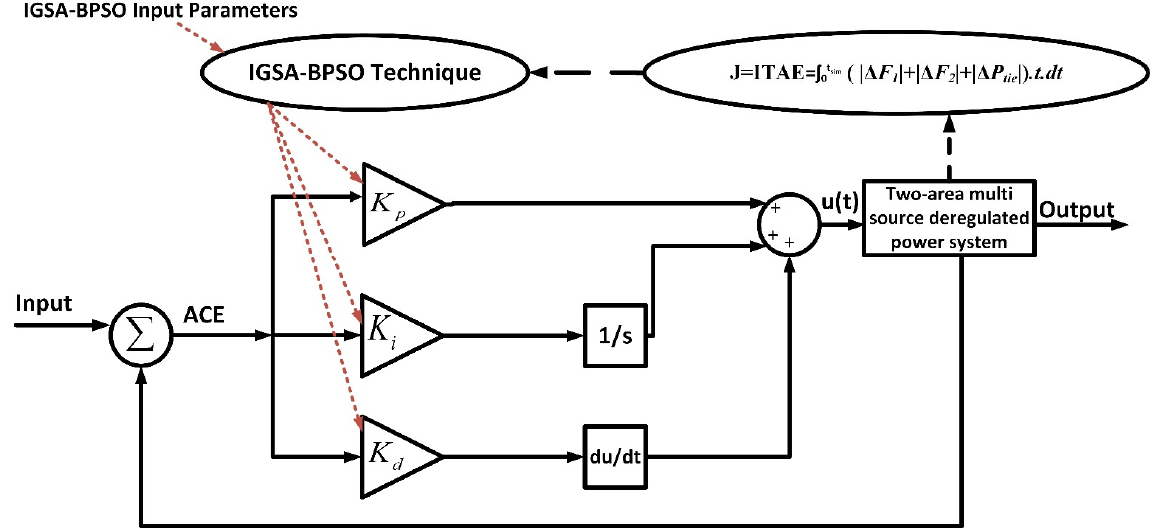
Figure 3. Schematic of proposed control scheme for the whole combined